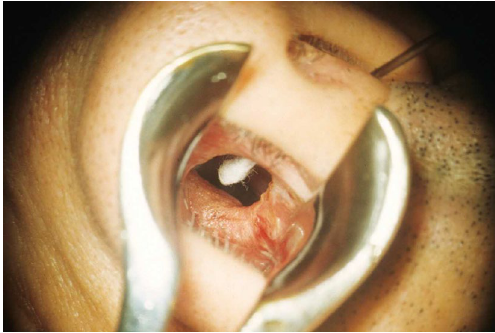
Figure 2. Perforation of the nasal septum due to occupational exposure to chromic